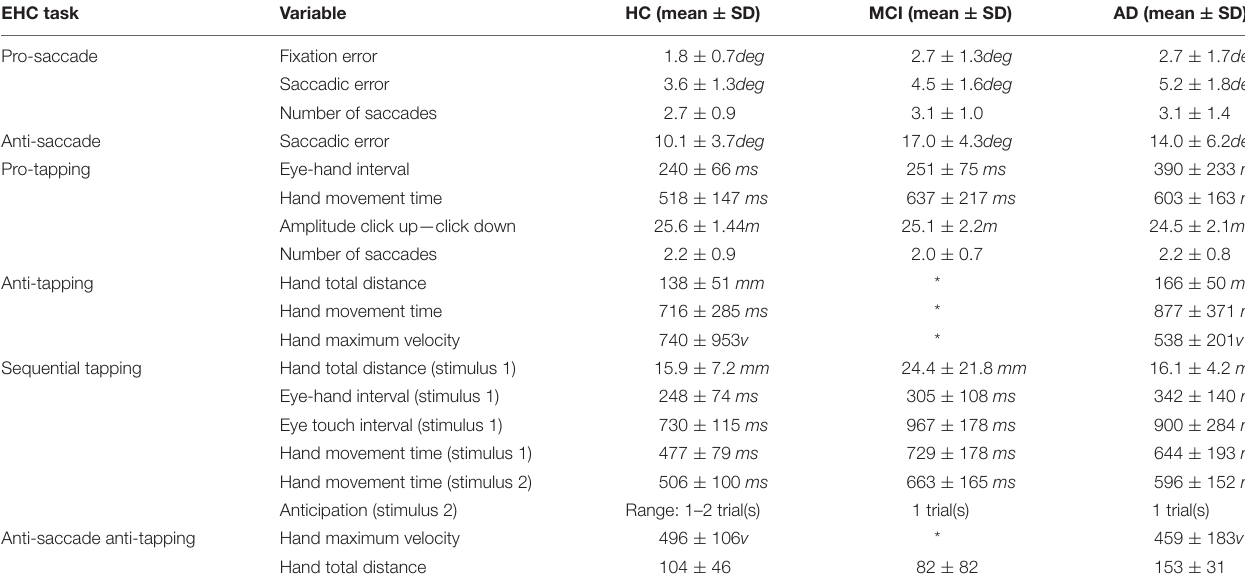
TABLE 3 | Descriptive statistics of the most important parameters per task.